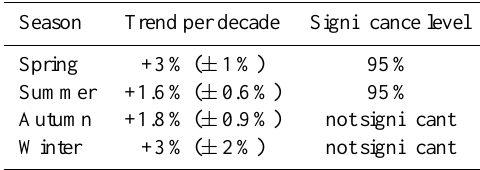
Table 5. Seasonal trends of aerosol optical depth at